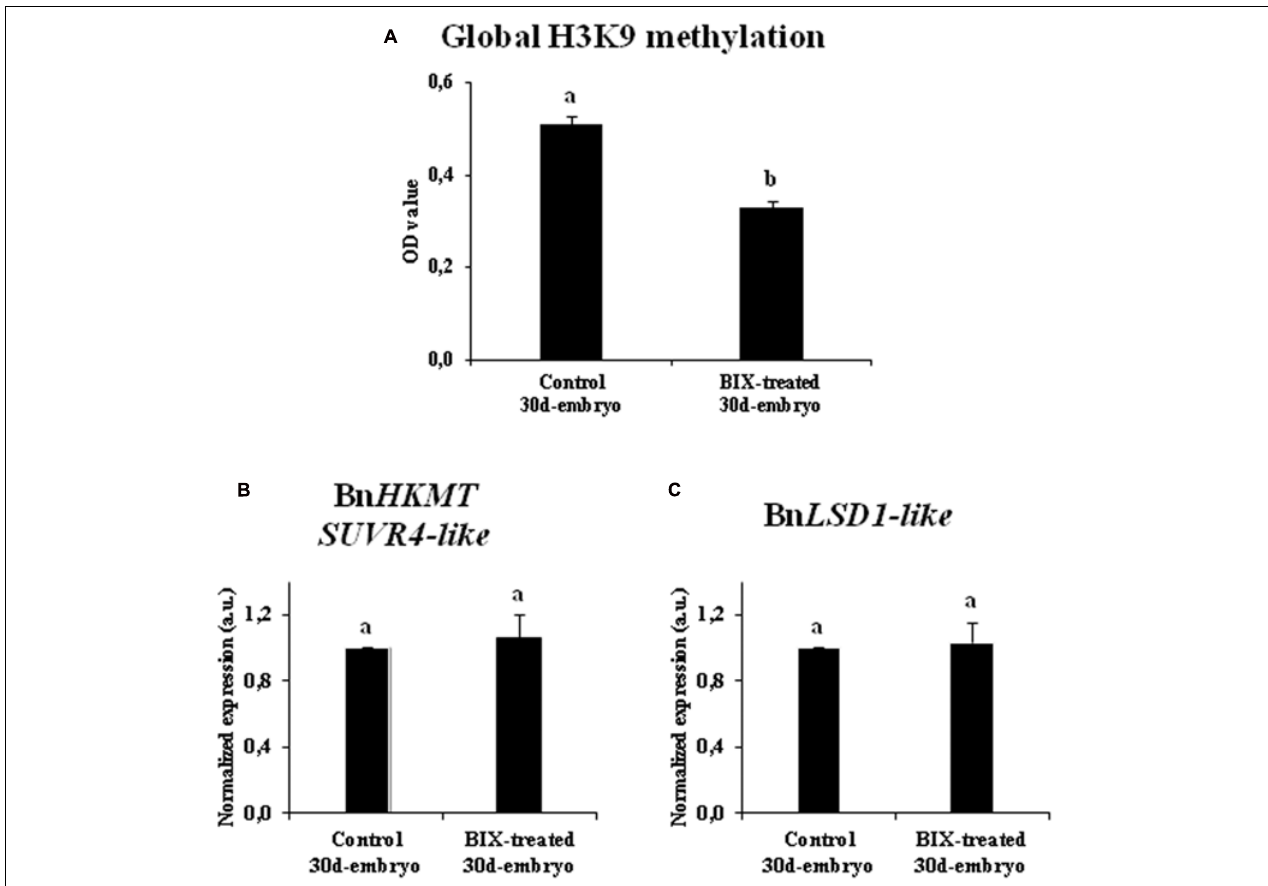
FIGURE 11 | Effects of BIX-01294 long treatments on H3K9 methylation levels and gene expression of BnHKTM SUVR4-like histone methyltransferase and BnLSD1-like demethylase. (A) : Quantification of global H3K9 methylation levels, represented as mean optical density (OD) units at 450 nm ( ± SEM), in control and 2.5 µ M BIX-treated embryos of Brassica napus , after 30 days in culture. (B,C) : Relative expression of histone methyltransferase BnHKTM SUVR4-like (B) and demethylase BnLSD1-like (C) in control and 2.5 µ M BIX-treated embryos, after 30 days in culture. Transcript levels were normalized to control embryo levels. Bars indicate the SEM. Different letters on columns indicate significant differences according to ANOVA and Tukey’s tests at p <